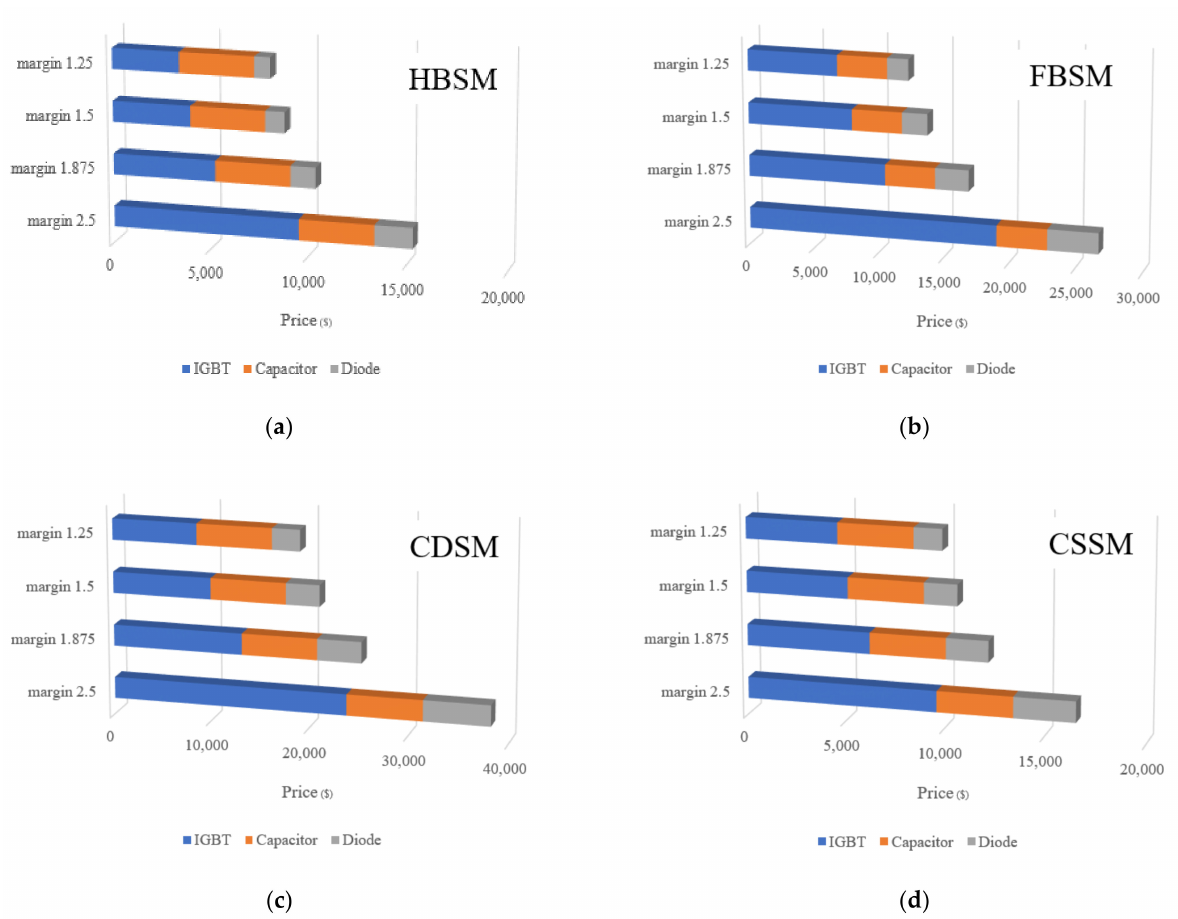
Figure 15. Price of circuit components according to voltage and current margin: ( a ) HBSM; ( b ) FBSM; ( c ) CDSM; ( d ) CSSM. Figure 16 is the result of the price comparison of submodules according to the voltage and current margin of switching devices. As the margin increases, the price of all submod- ules is exponentially increasing. However, it shows that the price difference between CSSM and HBSM is gradually decreasing.